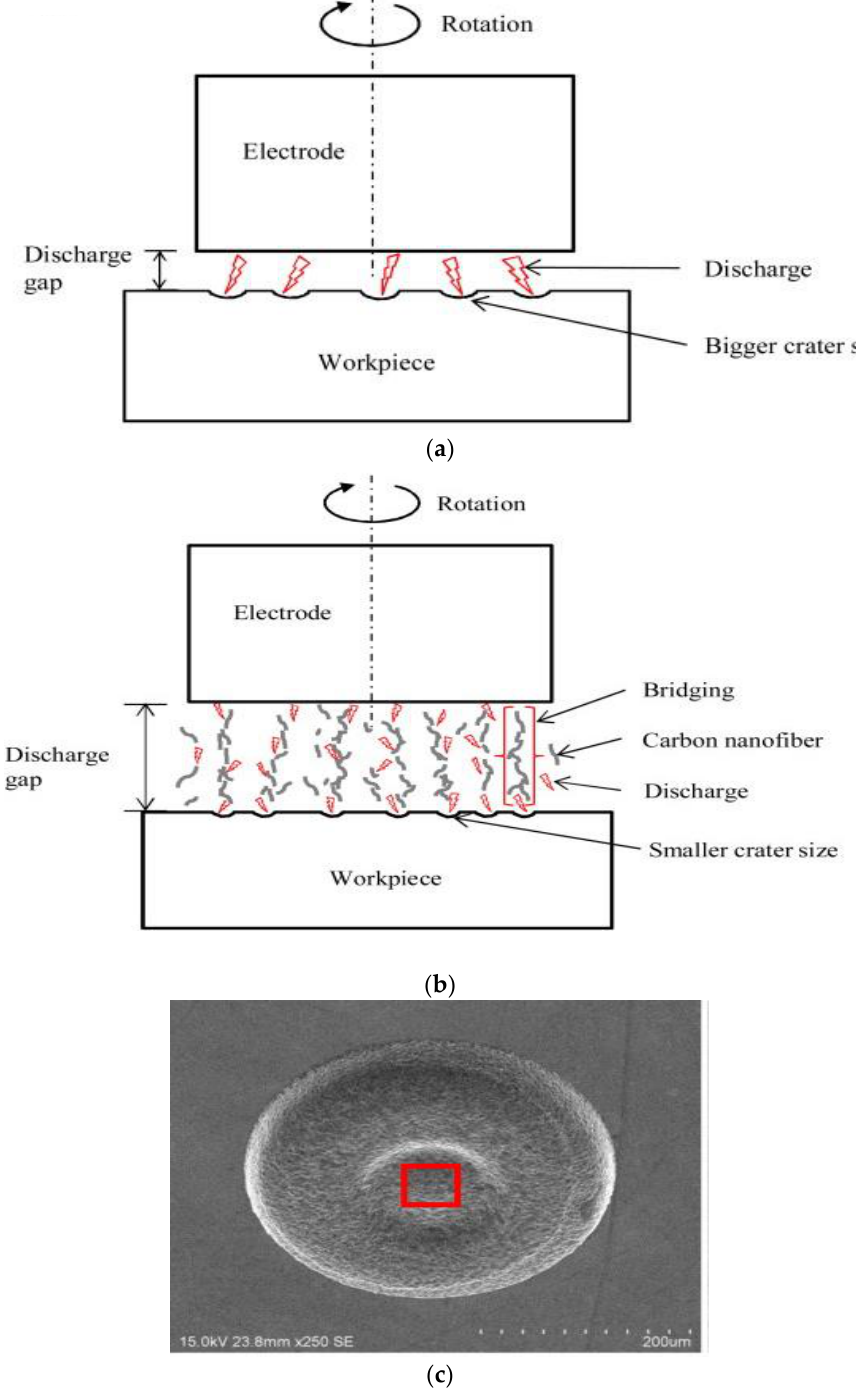
Figure 13. Schematic model for ( a ) conventional EDM and ( b ) carbon nanofiber assisted micro EDM, ( c ) machined surface at machining depth of 20 μm with 0.06 g/L carbon nanofibers . (Reproduced with permission from [47]).